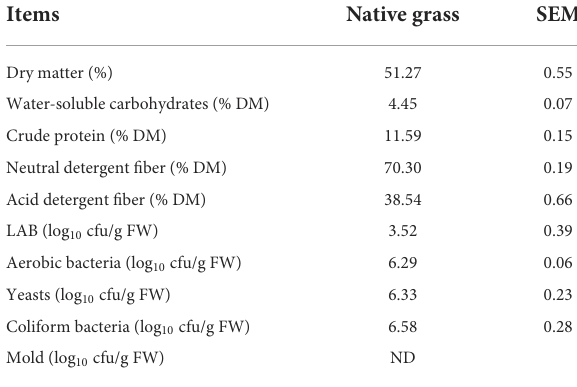
TABLE 1 Chemical and microbial compositions of substrates prior to ensiling. Items